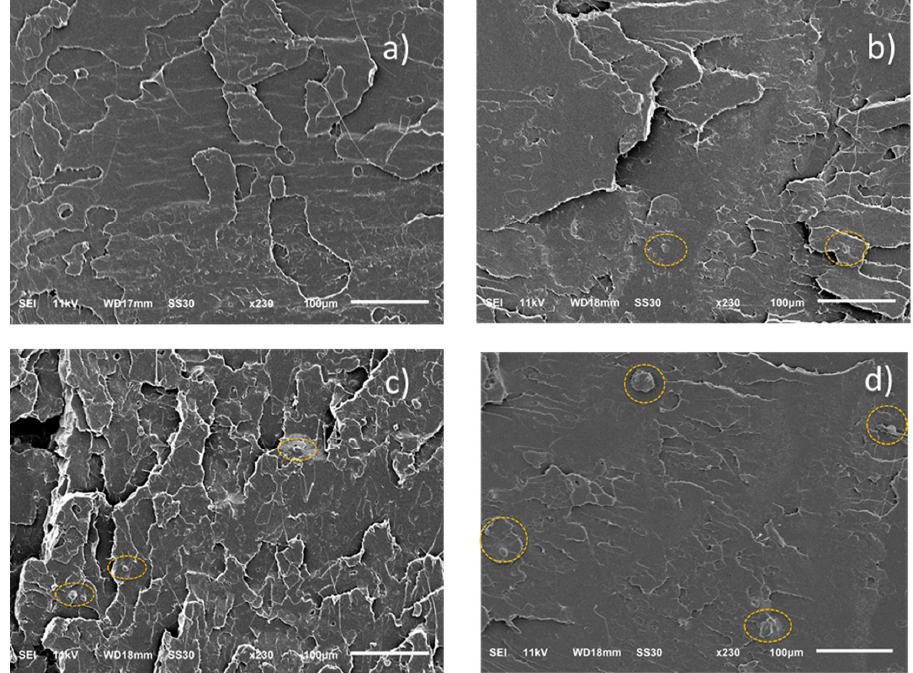
Figure 5. Scanning electron microscopy (SEM) images of fractured tensile surfaces of ( a ) PLA, ( b ) PLA + 1% MTPS, ( c ) PLA + 2% MTPS, ( d ) PLA + 5% MTPS.